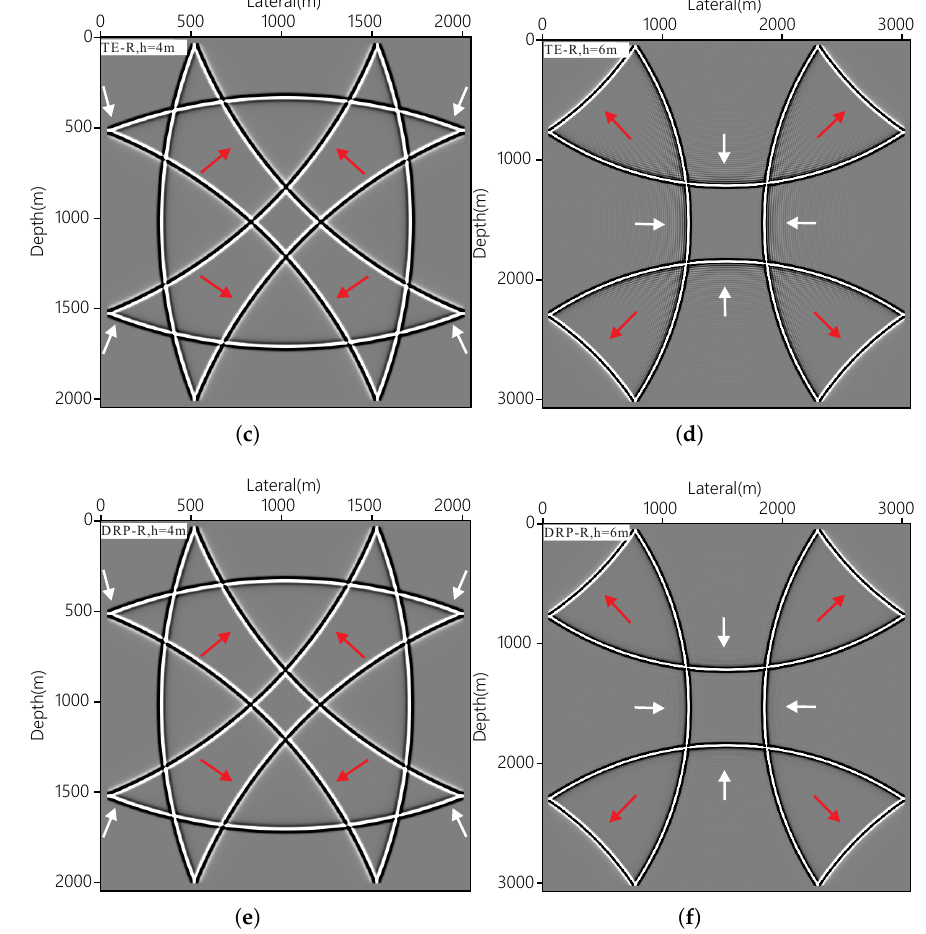
Figure 5. Numerical experiments of the homogeneous model with grid sampling h = 4 (m) and h = 6 (m). The left panel shows the snapshots with the grid sampling h = 4 (m), and the right panel represents the grid sampling h = 6 (m): ( a , b ) TE-C method, ( c , d ) TE-R method and ( e , f ) DRP- R